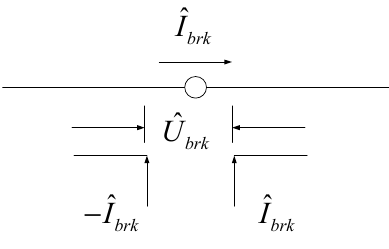
Figure 4. Breakpoint current